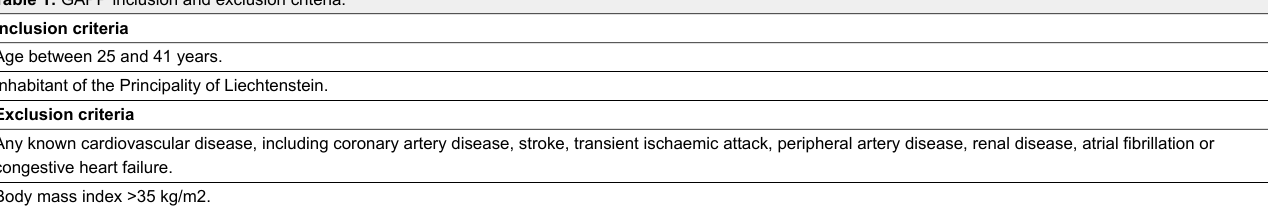
Table 1: GAPP inclusion and exclusion